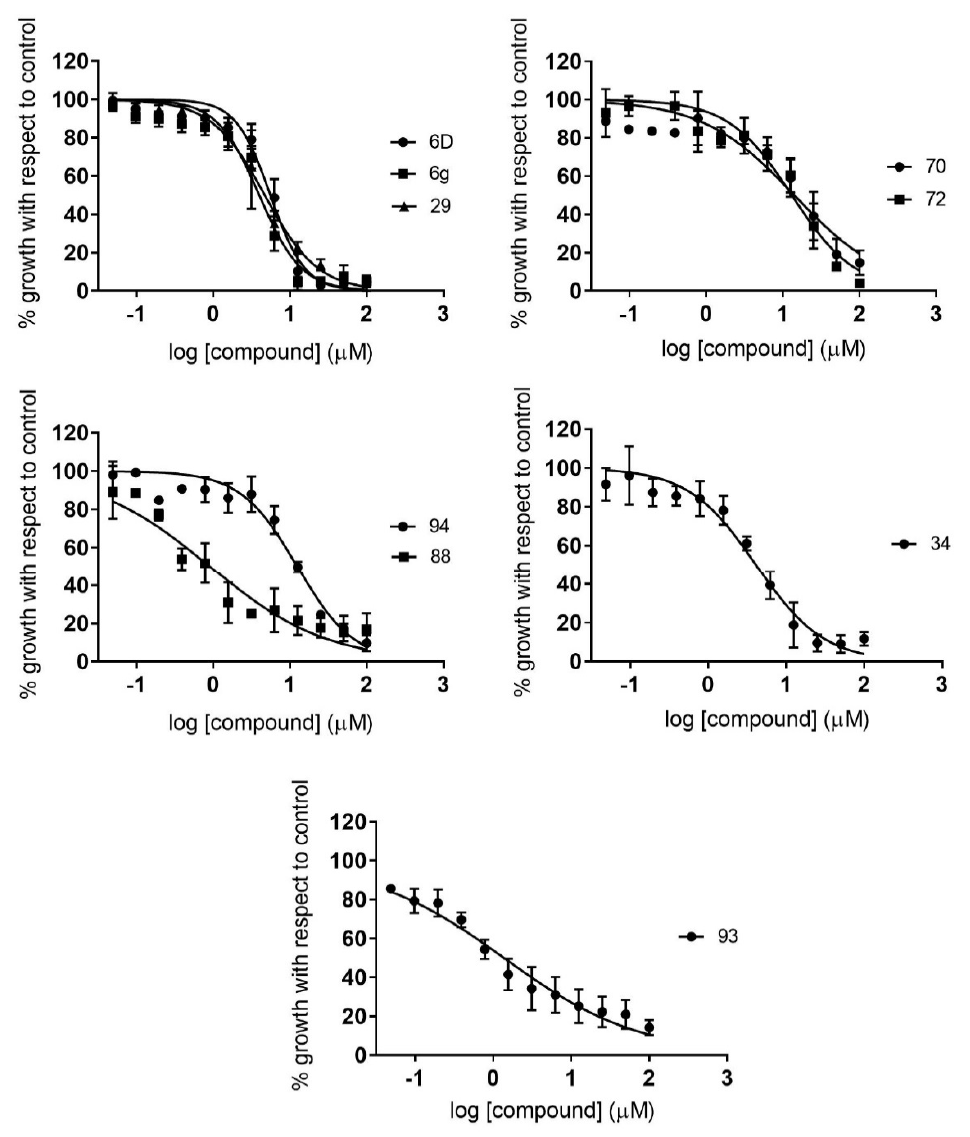
Figure 4. Dose–response curves of active compounds against T. cruzi , classified according to the different structural groups (from A to E). Graphs represent mean values and SD results of at least three independent replicas.